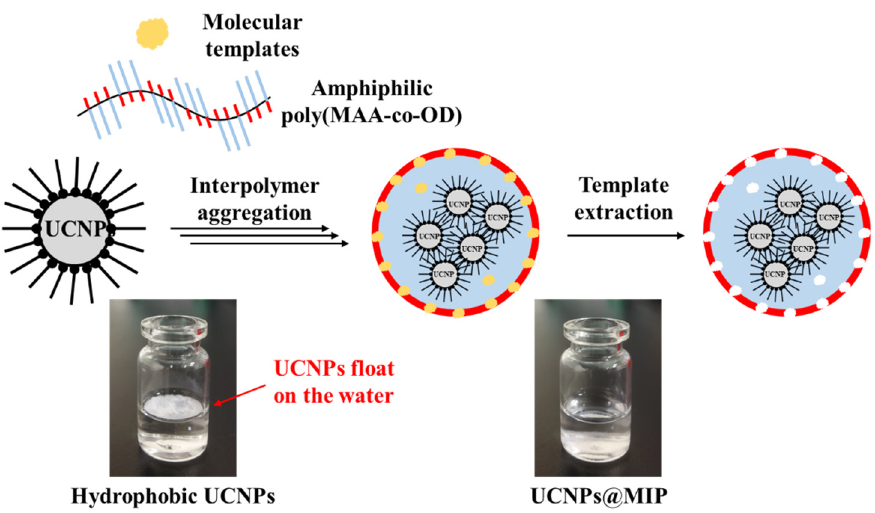
Figure 2. Schematic representation of preparation of UCNPs@MIP.